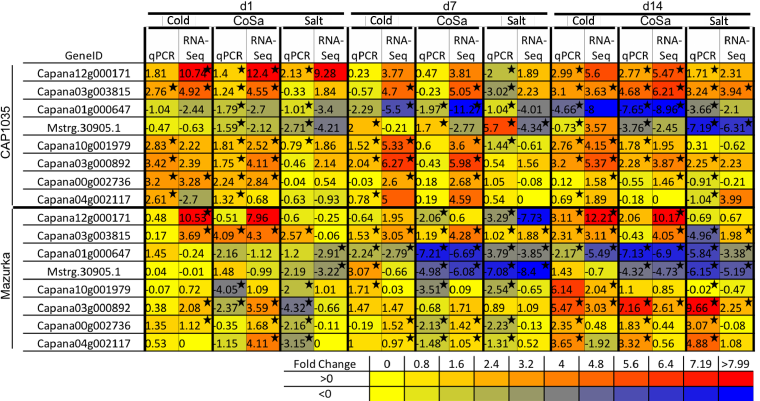
Figure A5. Verification of RNASeq data by quantitative realtime PCR. RNASeq data were verified using samples from an independent biological experiment performed within the same plant chambers under the same stress conditions as before. Mazurka and CAP1035 were grown on rockwool for six weeks before applying chilling temperatures (Cold), 200mM salt (Salt) or a combination thereof (CoSa). A total of 1, 7 and 14 days after treatment induction the expression of indicated genes was determined in 4 biological replicates per treatment. The results are expressed as log 2 (fold change compared to the control sample). Significance is indicated for p < 0.001 as asteriks, or an FDR < 0.01 for RNASeq data.